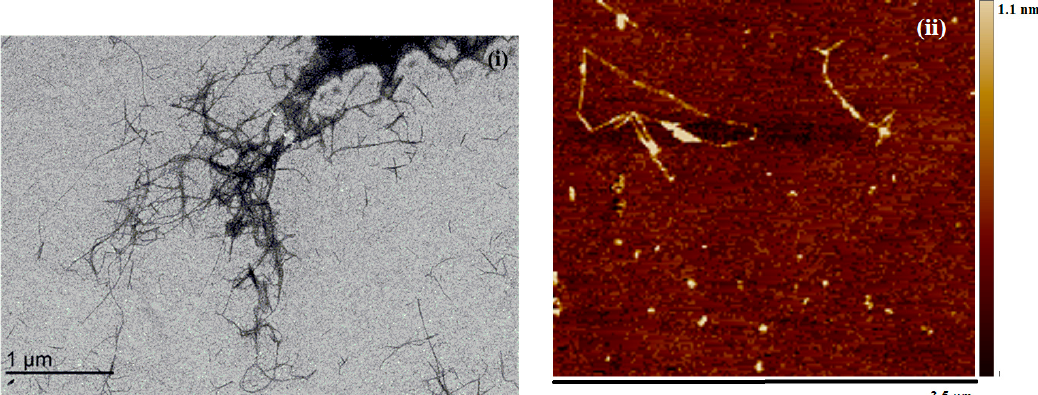
Figure 2. ( i ) Transmission electron microscopy (TEM) and ( ii ) atomic force microscopy (AFM) of NOCNF extracted from raw jute fibers.